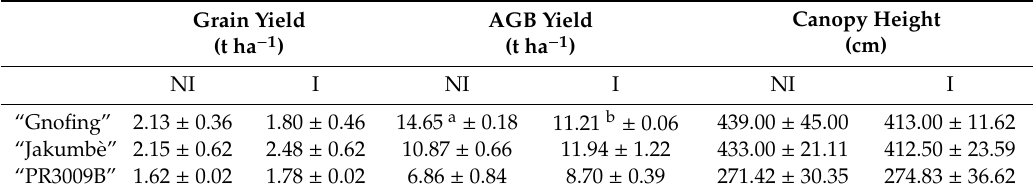
Table 2. Sorghum grain yield and above-ground biomass (AGB) of different cultivars in N ’ Gakoro 2019. Sowing date: 13 July 2019, Harvest: 31 October 2019.